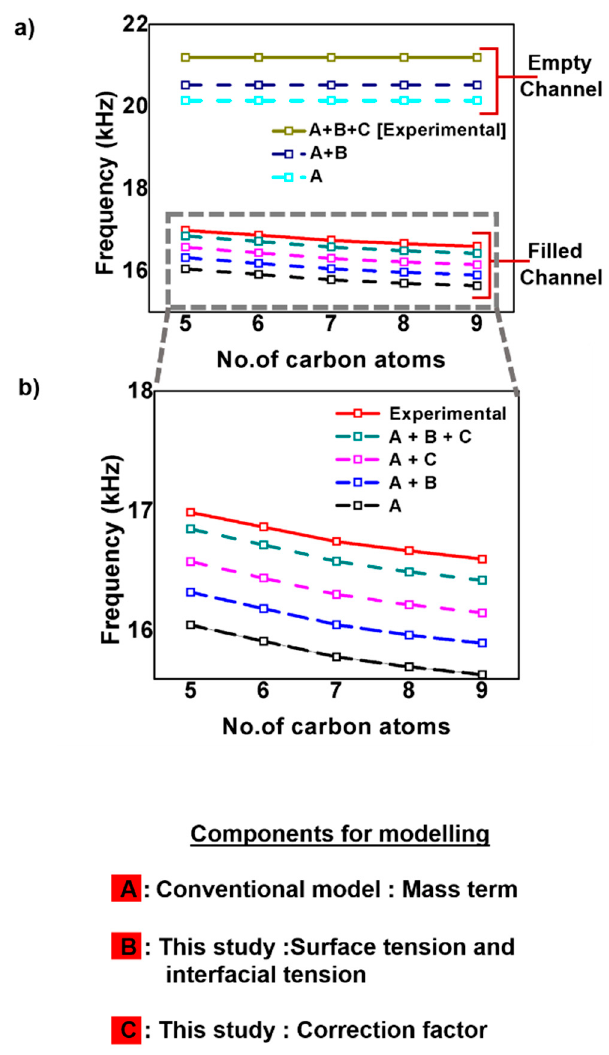
Figure 4. ( a ) Experimentally observed (solid lines) and theoretically predicted (dashed lines) resonance frequencies of the microchannel cantilever. ( b ) Enlarged view of the values from the channel filled with alkane liquids with varying carbon atoms in the chain.